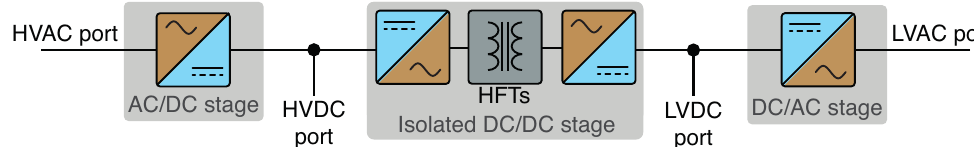
Figure 3. Three-stage SST architecture (adopted in